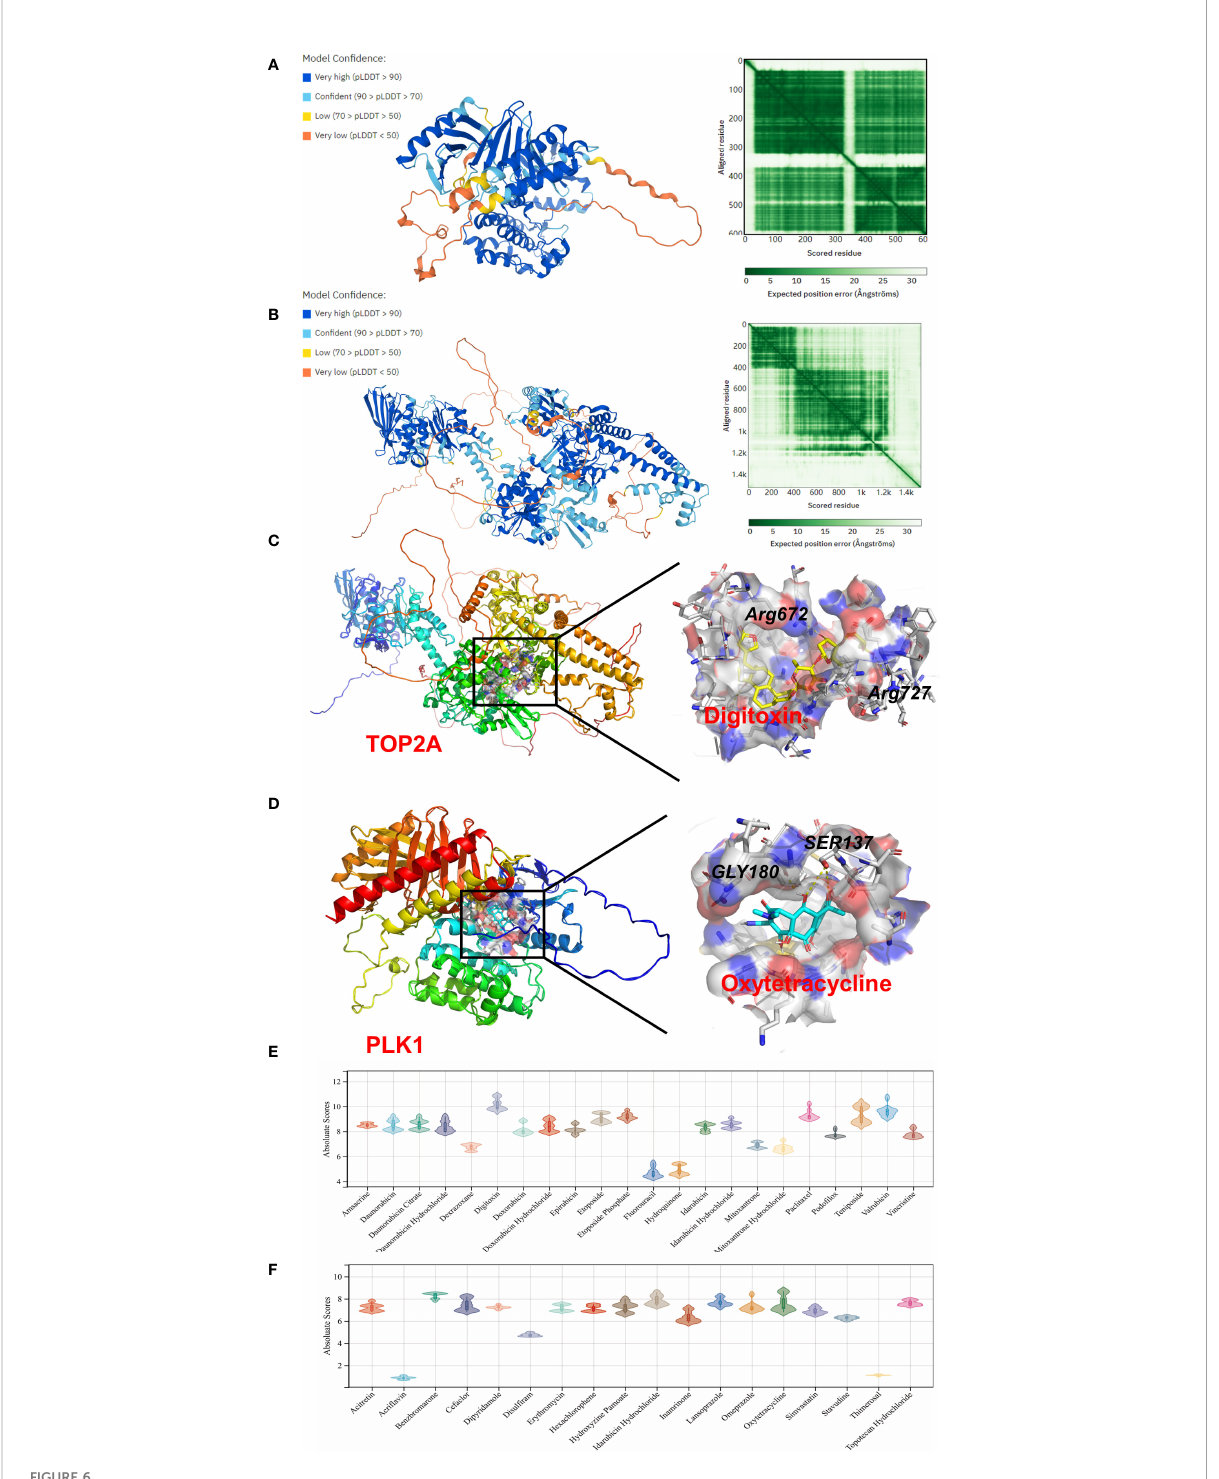
FIGURE 6 Homology modeling and molecular docking results. The crystal structure and evaluation of (A) TOP2A and (B) PLK1. The best docking positions (C) between digitoxin and TOP2A or (D) between oxytetracycline and PLK1 are indicated. The absolute value of af fi nity between predicated small molecules and (E) TOP2A or (F) PLK1 was